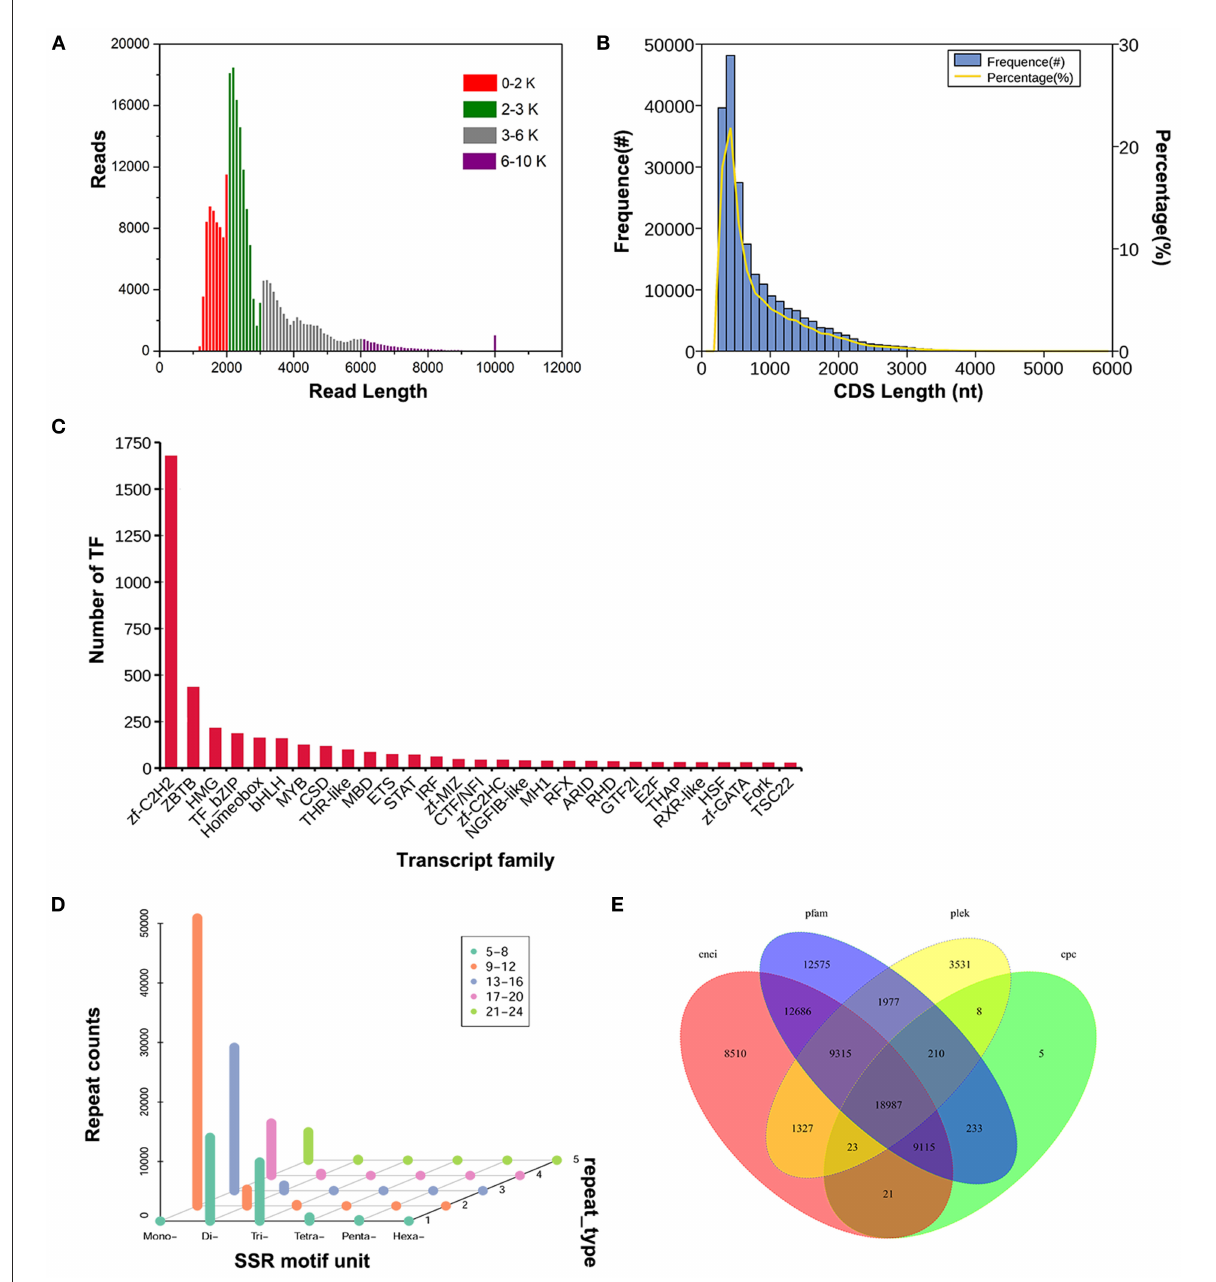
FIGURE1 Structure analysis of Sika Deer full-length transcriptome data. (A) Length distribution of Sika Deer reads in four fragment size ranges. (B) Number, percentage and length distributions of coding sequences of transcripts. (C) Transcription factor statistic. (D) Scattergram of SSR of transcripts. (E) Venn diagram of the number of lncRNAs predicted by CNCI, Pfam, PLEK, and CPC protein structure domain